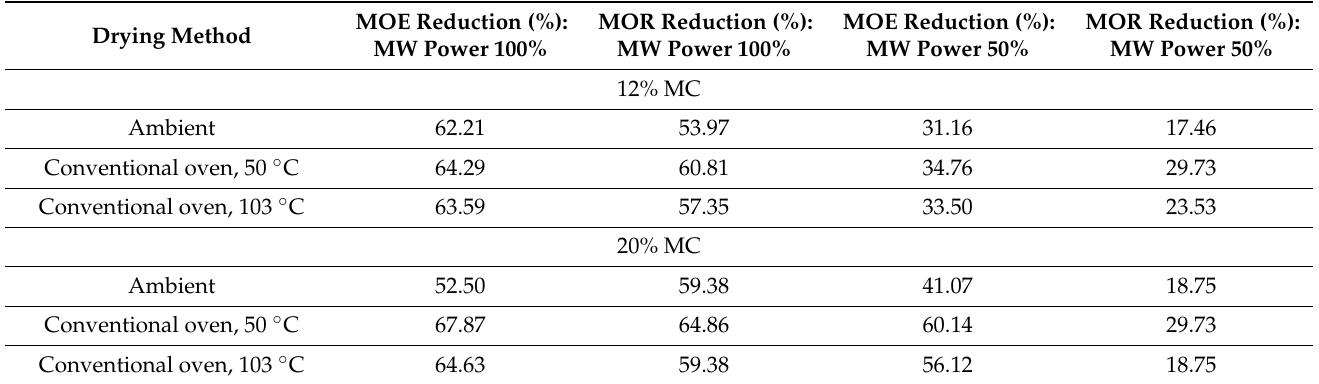
Table 1. MOE and MOR percentage reduction according to